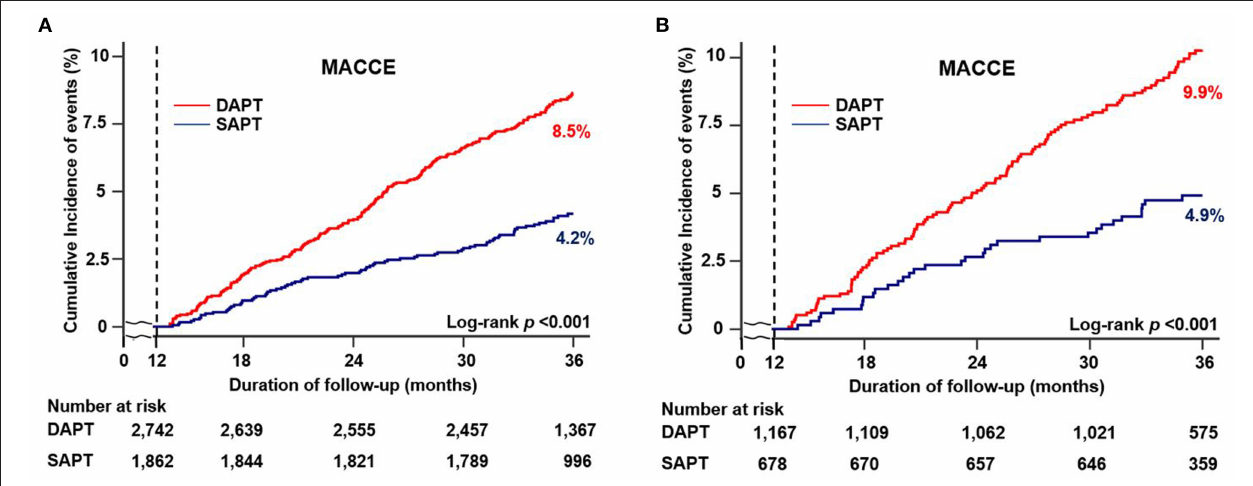
FIGURE 2 | Cumulative incidence of clinical outcomes according to antiplatelet agents between 12 and 36 months. Kaplan–Meier curves comparing the rates of MACCE between SAPT and DAPT in (A) all patients and (B) patients with complex features. MACCE, major adverse cardiac and cerebrovascular events; SAPT, single antiplatelet therapy; DAPT, dual antiplatelet